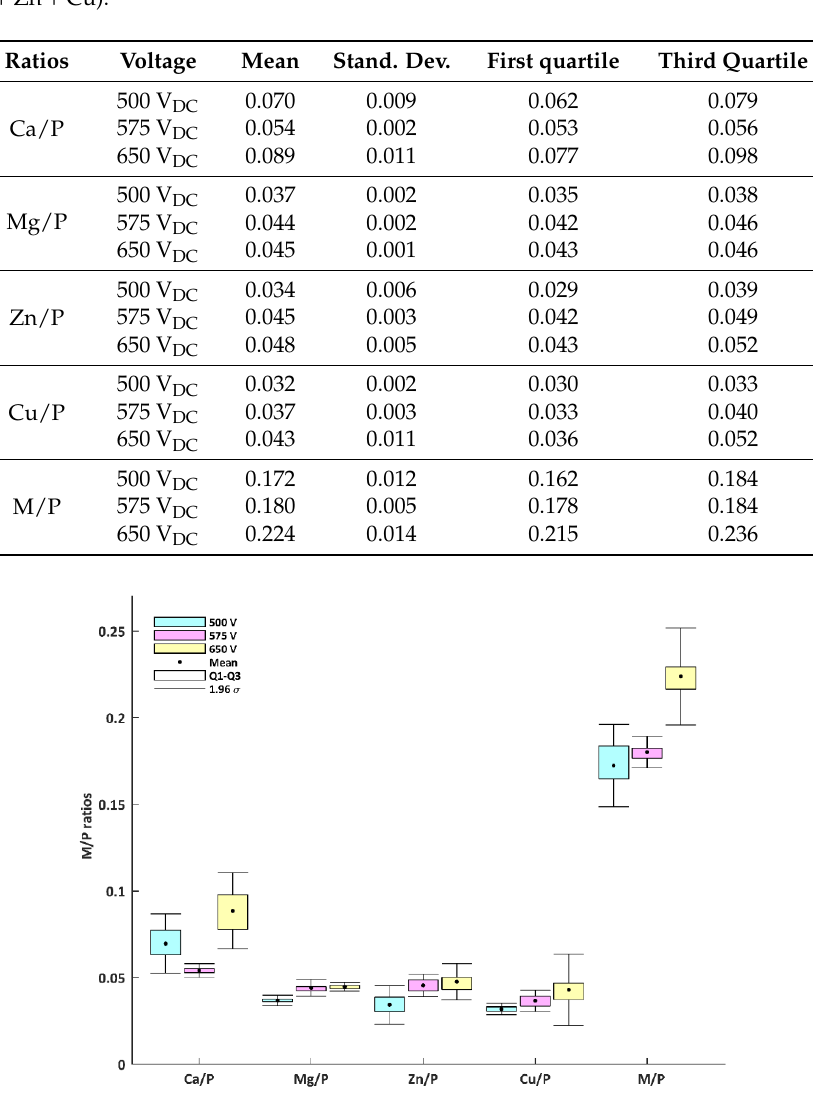
Figure 2. EDS results as Ca/P, Mg/P, Zn/P, Cu/P and M/P (M = Ca + Mg + Zn + Cu) ratios measured for coatings formed on CP Titanium Grade 2 after PEO process at the voltages 500 V DC , 575 V DC , 650 V DC in 1 L of 85% H 3 PO 4 with additions of 125 Ca(NO 3 ) 2 · 4H 2 O, 125 g Mg(NO 3 ) 2 · 6H 2 O, 125 g